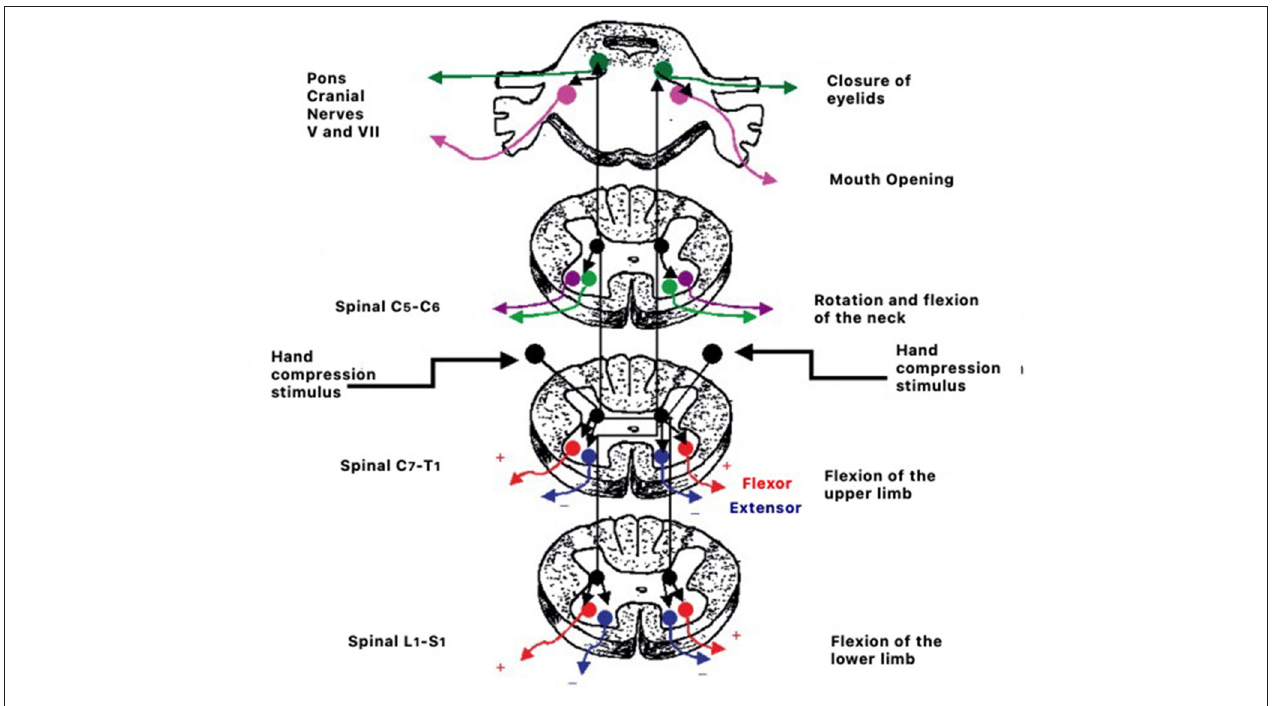
FIGURE 2 | Example of the circuitry of reflex responses to hand compression